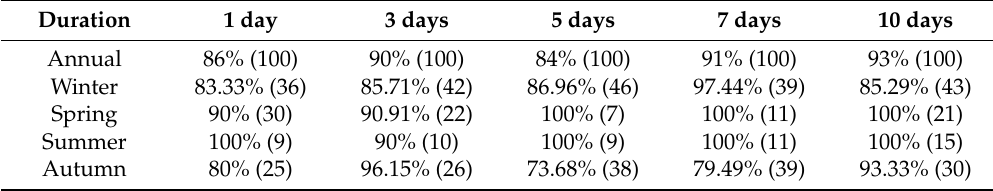
Table 3. Numbers of extreme events on annual and seasonal scales (within brackets) and percentages of extreme precipitation events with a higher Mediterranean Sea contribution than the mean annual and seasonal climatological value for all rainy length periods of 1, 3, 5, 7, and 10 days. Results are presented with respect to Mediterranean PFLEX anomalies into the Danube River Basin.